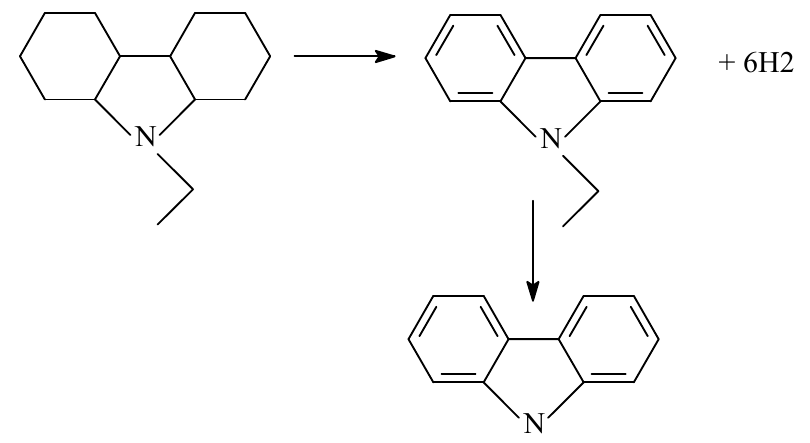
Figure 6. N-Ethylcarbazol as a hydrogen storage material.